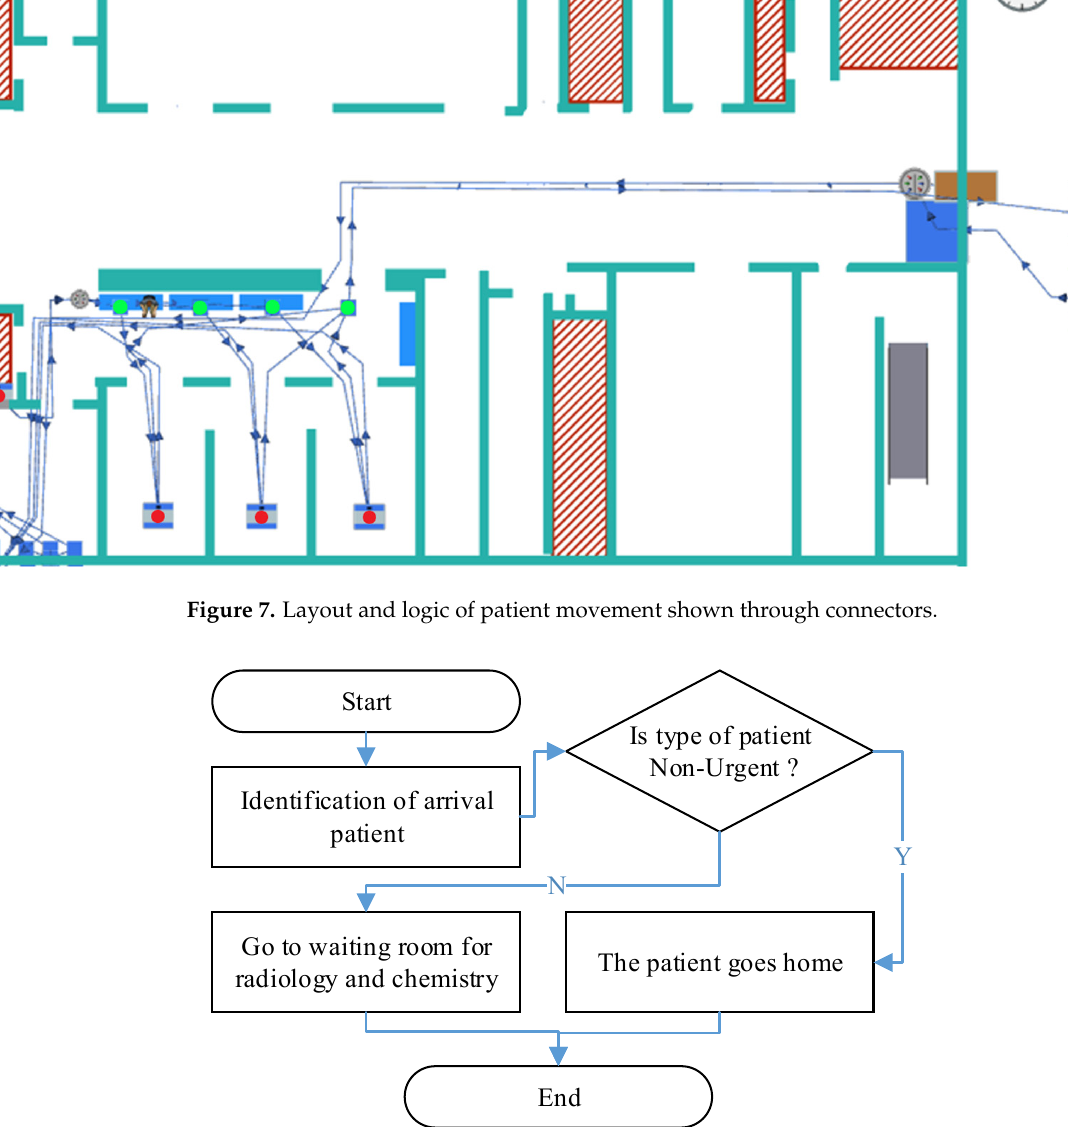
Figure 8. Logic of patient decision making at the exit of the surgical ambulance, schematically. The symbols and colours on the layout represent the following objects: turquoise represents the walls dividing the space, the red hatched part represents the rooms where disinfection is not carried out by AGV, the grey lines are the access routes of the disinfection ground AGV along which movement is possible in both directions, and the orange lines are the individual disinfection routes, which are unidirectional. The basic logic of the path was to control the possibility of assigning another task if there was no AGV task in the queue. The AGV returned to the parking place. If the task is in the queue, the AGV starts performing it and indicates that it is being performed. If the battery level is insufficient, the AGV returns to the charging station (Figure